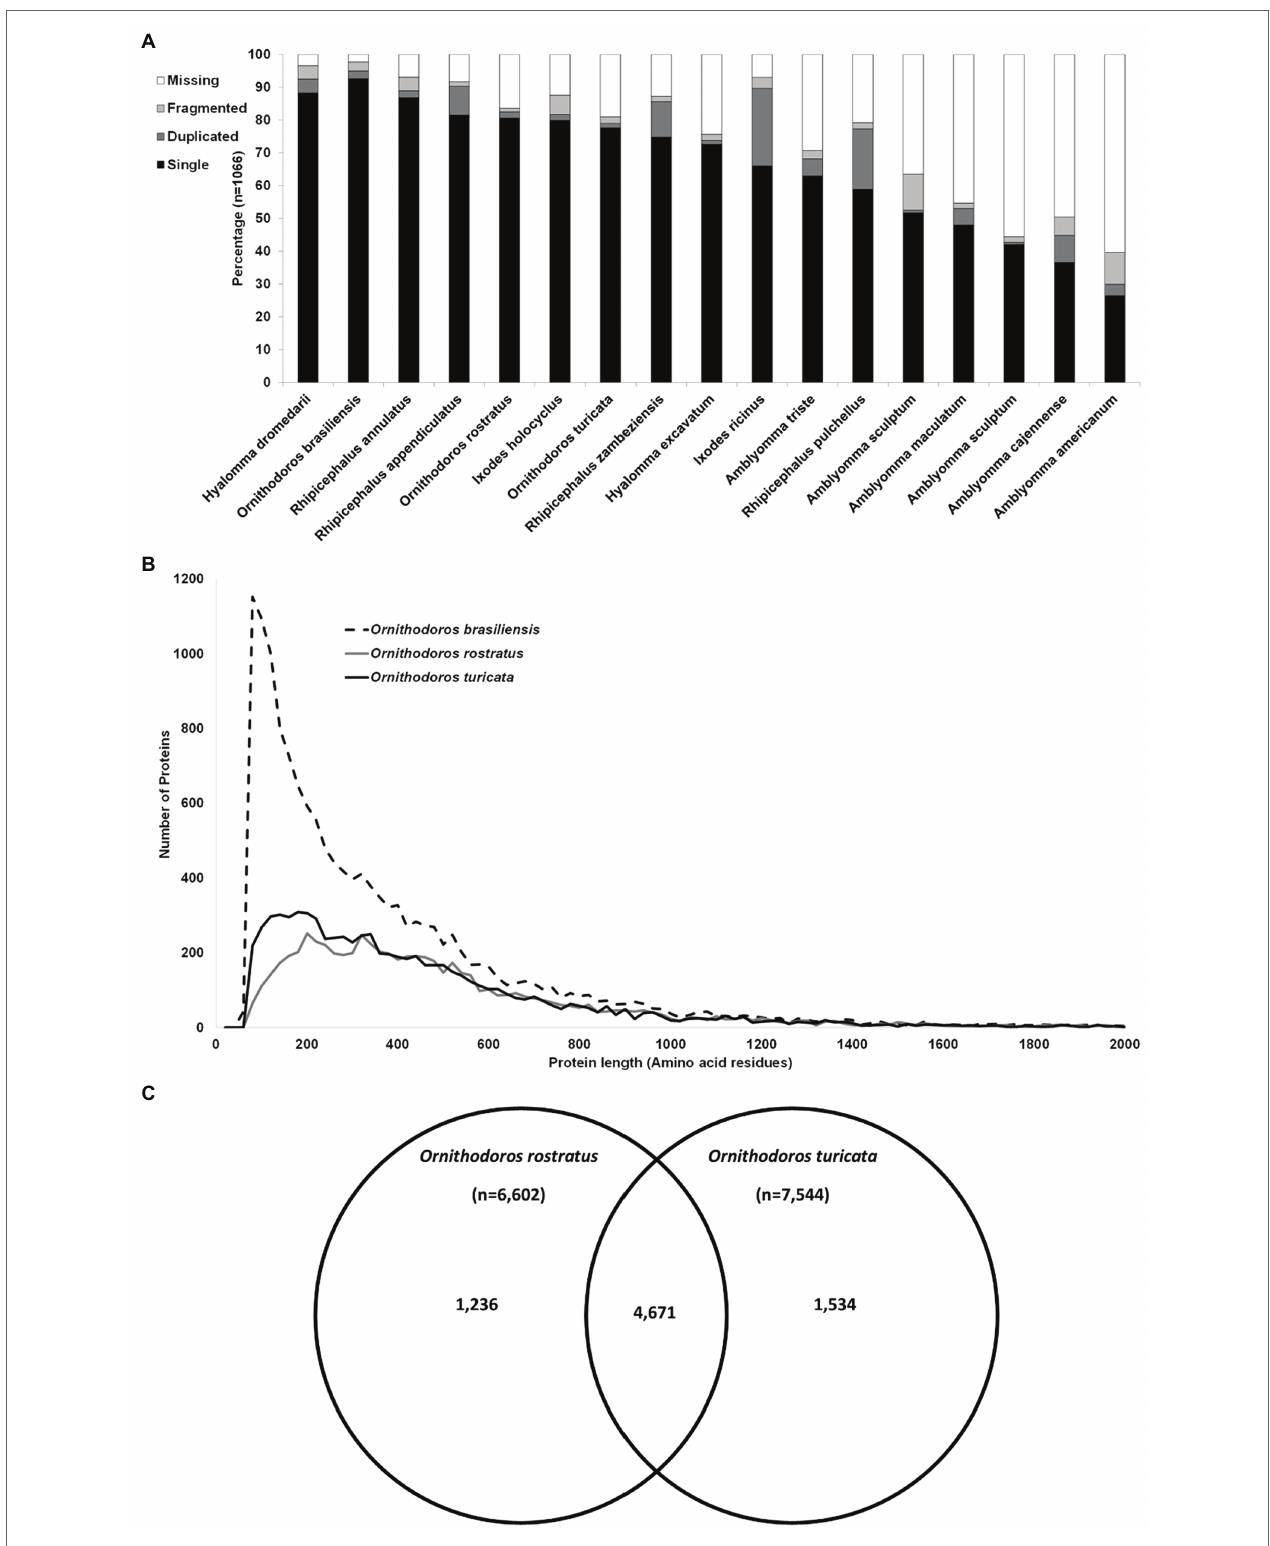
FIGURE 1 | Quality assessment of the transcriptome. (A) Comparison of the BUSCO analysis of all published salivary gland transcriptomes and Ornithodoros brasiliensis . The species are indicated on the horizontal axis, while the percentage of single complete, duplicated complete, missing, and fragmented is indicated